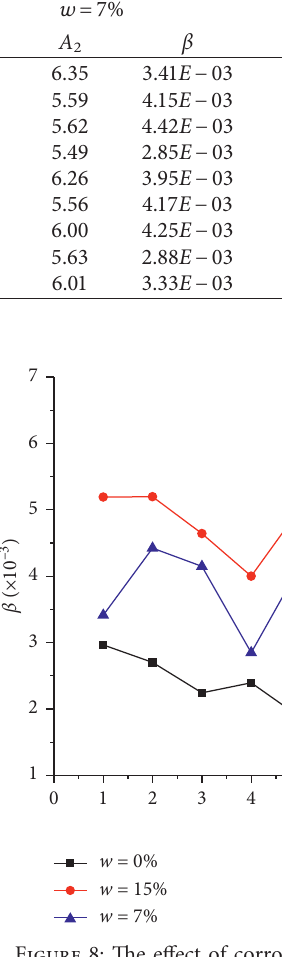
Figure 8: The effect of corrosion rate on the value of β 2 .